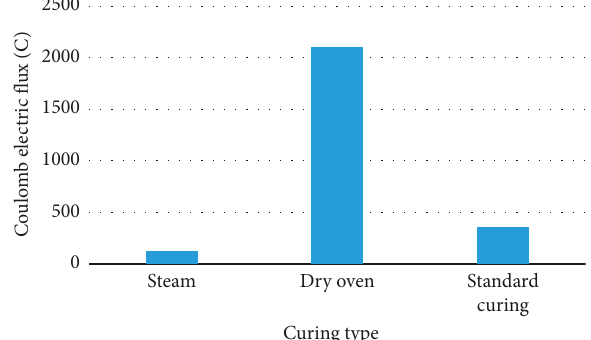
Figure 11: Chloride permeability test of concrete specimens with a W/B ratio of 0.35 prepared and cured under different conditions at a temperature of 50 ° C.